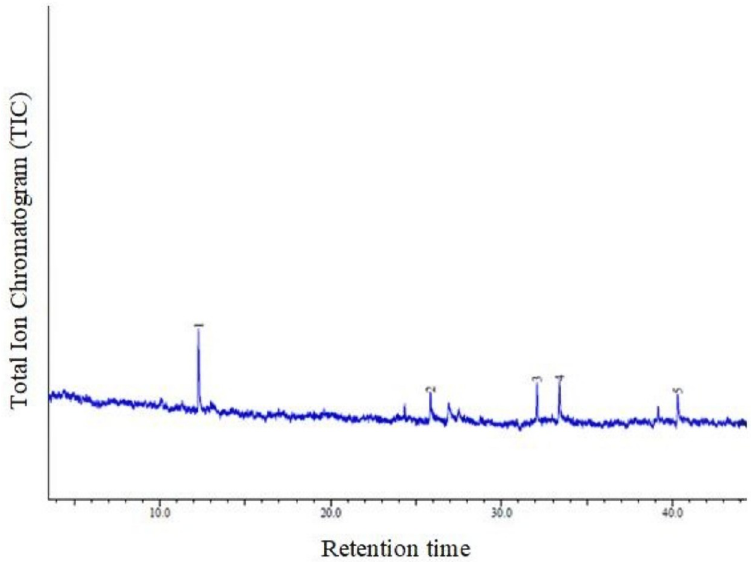
Fig 5. Chromatogram for GC-MS analysis for Areca catechu nut. (ACQUISITION PARAMETERS; RTX5 capillary column 30 m × 0.25 mm inner diameter, × 0.25 μ m film thickness, the oven temperature was programmed from 80˚C (hold for 2 min) to 280˚C at a rate of 3˚C/min Carrier Gas = He).